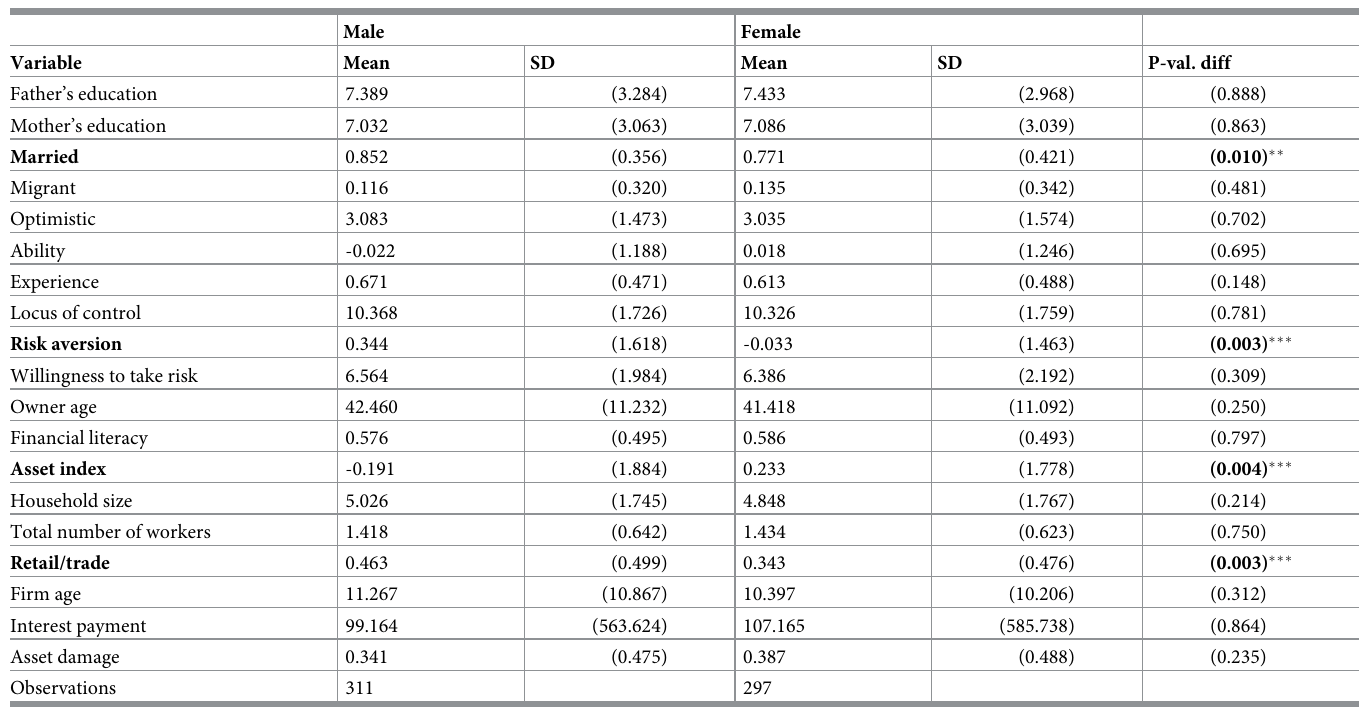
Table 4. Balance test: Male owners versus female